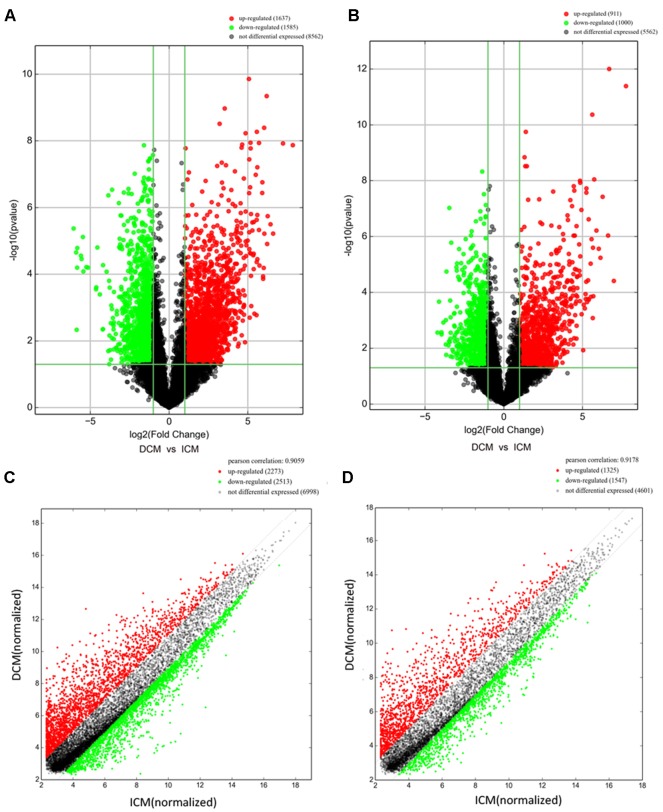
The volcano plots and scatter plots of long noncoding RNA (lncRNA) (A, C) and messenger RNA (mRNA) (B, D) expression variation between the dilated cardiomyopathy (DCM) and ischemic cardiomyopathy (ICM) patients. Expression values of 11,784 lncRNA and 7,473 mRNA in DCM and ICM patients were converted to log2 (fold change) and were compared to −log10 (p-value) using a volcano plot. A threshold of p 0.05 and fold change ≥2.0 (The red dots represented upregulated, the green dots represented downregulated). Scatter plots indicated the normalized signal values of the plasma sample (log2 scaled).The red dots represented upregulation and fold change ≥ 2.0, the green dots represented downregulation and fold change ≥ 2.0.